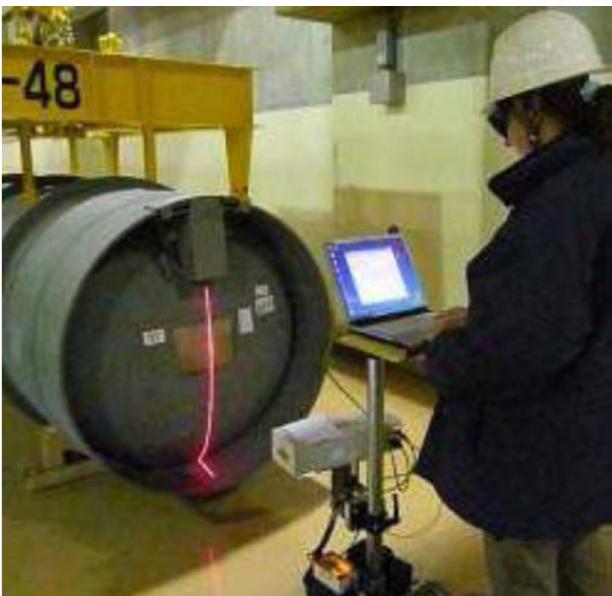
Fig. 6. Nuclear facilities veri fi cation